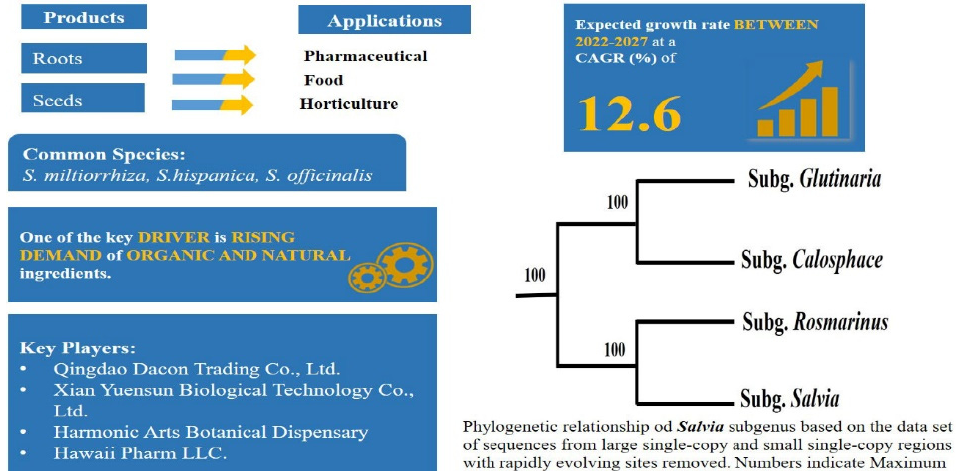
Figure 8. Salvia products, applications and phylogenetic relationship among subgenera.